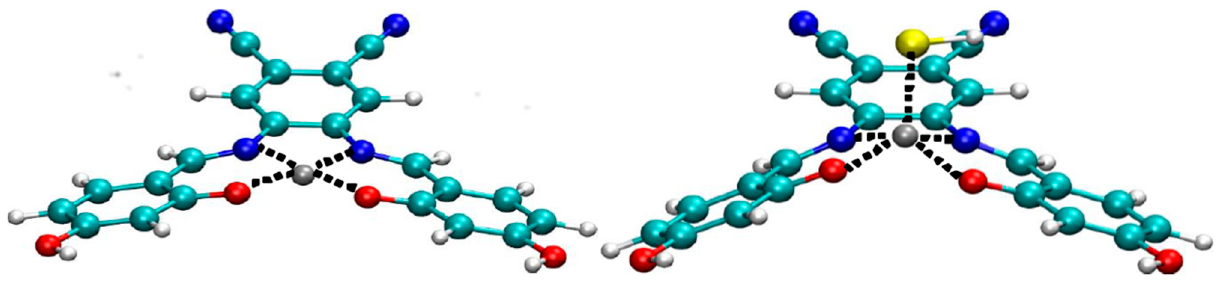
Figure 9. Optimized geometries for complex 1 ( left ) and its adduct with HS – ( right ). Complexes 1 and 4 deviate from the square planar nuclear configuration observed for salen-analogues [41,42], with the metal atom in the plane of the ligand (see Figure 9). The formation of the single adduct is predicted to be exergonic ( Δ E = − 0.86 eV for complex 1 , ∆ E = − 0.92 eV for complex 4 ), whereas the double adduct is not predicted to be a stable species, as confirmed by the DFT computation where the second HS – was moved away from the metal centre during the geometry optimization.